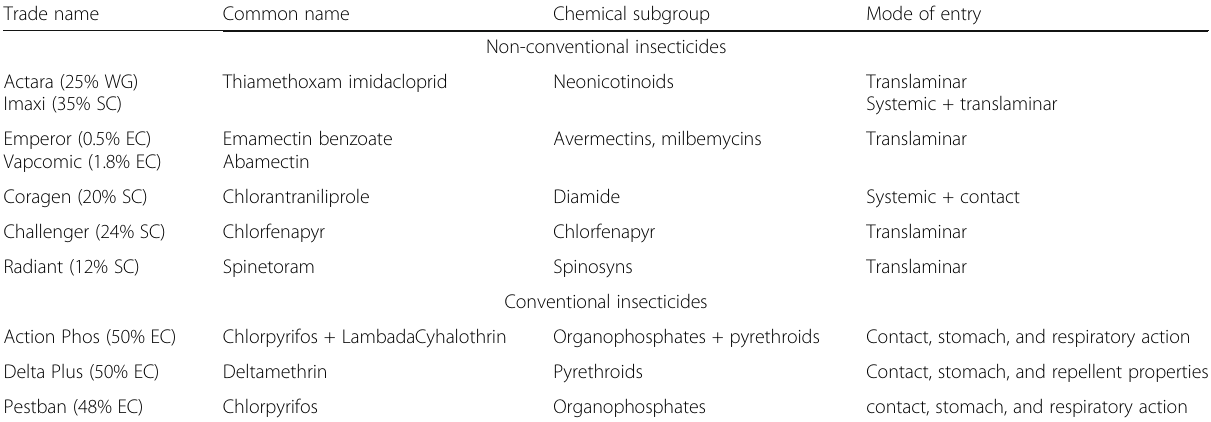
Table 1 Insecticides used for controlling Tuta absoluta